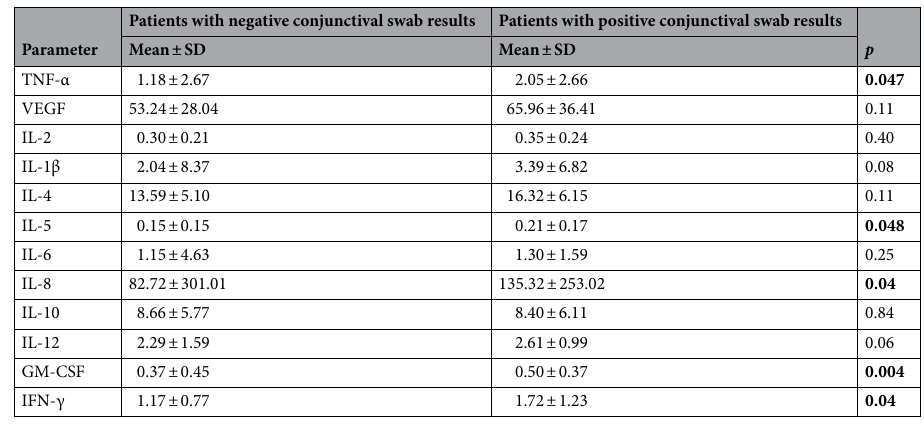
Table 3. Tear film cytokine levels among patients with positive and negative conjunctival swab results (pg/ mL). Statistically significant p values are shown in